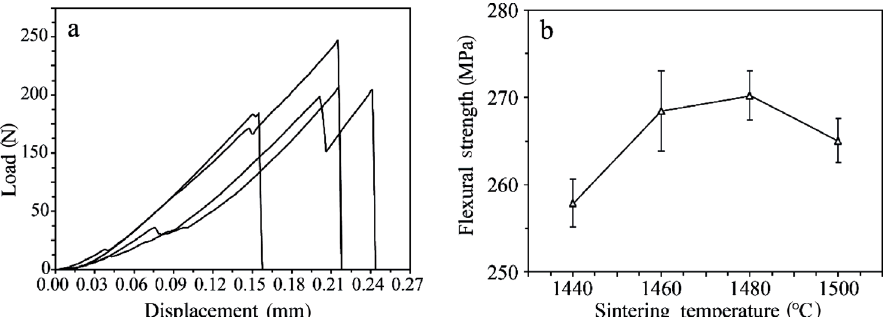
Fig. 7 Flexural strength of co-continuous composites at RT: (a) load–displacement curves, (b) flexural strength.